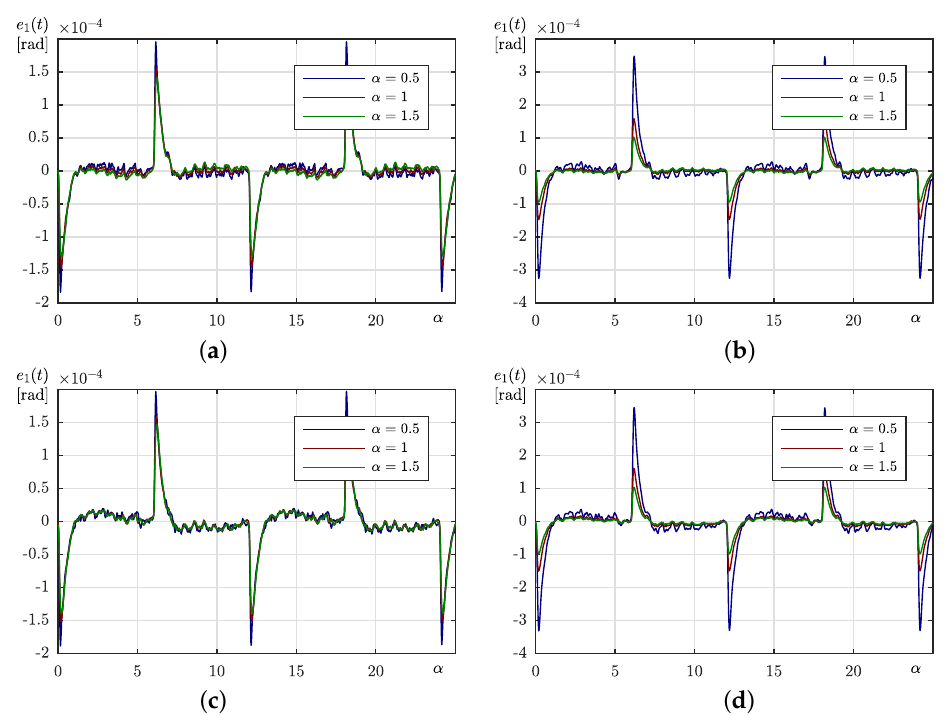
Figure 6. A comparison of the steady-state tracking error for fast trajectory: ( a ) CO, ( b ) CFO, ( c ) EO, ( d )